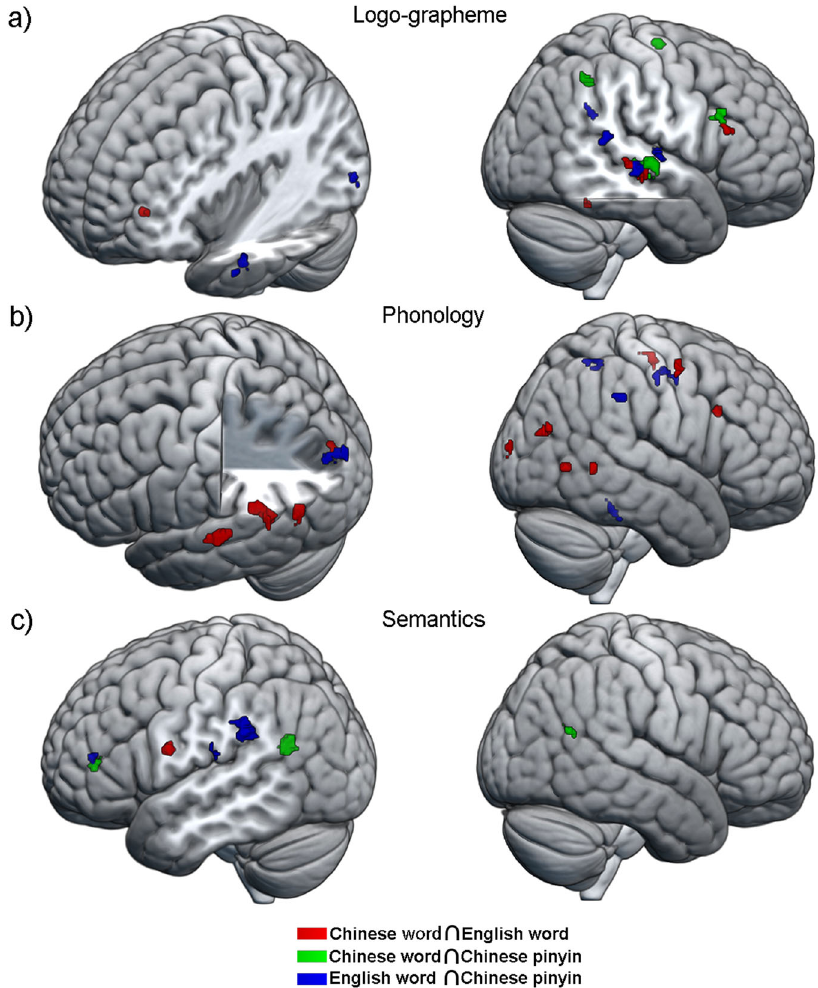
Fig. 5 Overlap of brain involvement among language types in each linguistic component. The overlapping patterns of brain load for a logo-grapheme, b phonology, and c semantics between pairs of languages. Red represents overlapping brain involvement between Chinese words and English words; green signi fi es overlapping brain activity between Chinese words and Chinese pinyin; and blue indicates an overlap in brain activity between English words and Chinese